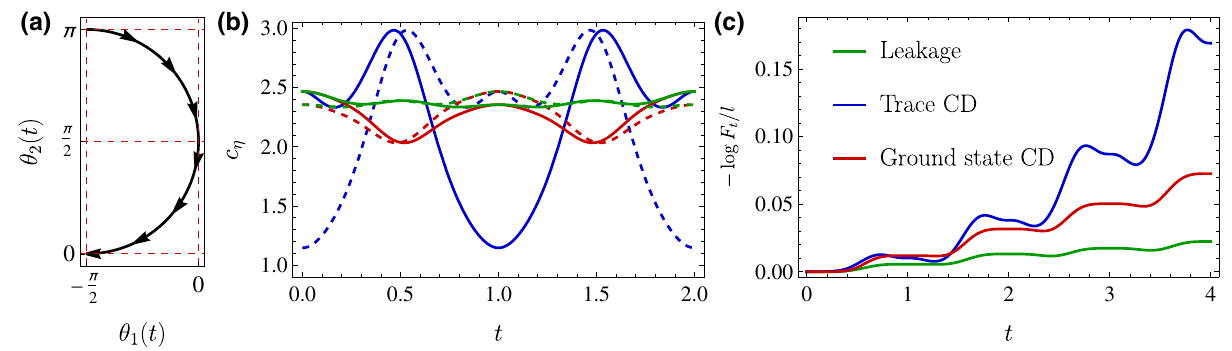
FIG. 2. We compare different approaches to the control problem shown in Fig. 1. Panel (a) shows the desired trajectory in the plane of angles θ 1 , θ 2 that parameterize the MPS, which closely resembles the scarred trajectory [8,39]. Panel (b) shows the optimal value of driving parameters obtained from trace-CD (blue), ground-state CD (red), and leakage-based (green) optimization. Full and dashed lines correspond to c 1 and c 2 , respectively. The leakage approach yields a nearly constant value of driving parameters along the full trajectory. Finally, panel (c) shows the time dependence of the logarithm of fidelity [ F t = |(cid:4) ψ( t ) | ψ Q ( t ) (cid:2)| 2 ] per site computed using the infinite TEBD approach [49], illustrating that the leakage approach outperforms CD-based approaches. All data shown are computed using a bond dimension of χ = 64 and a time step δ t = 10 − 5